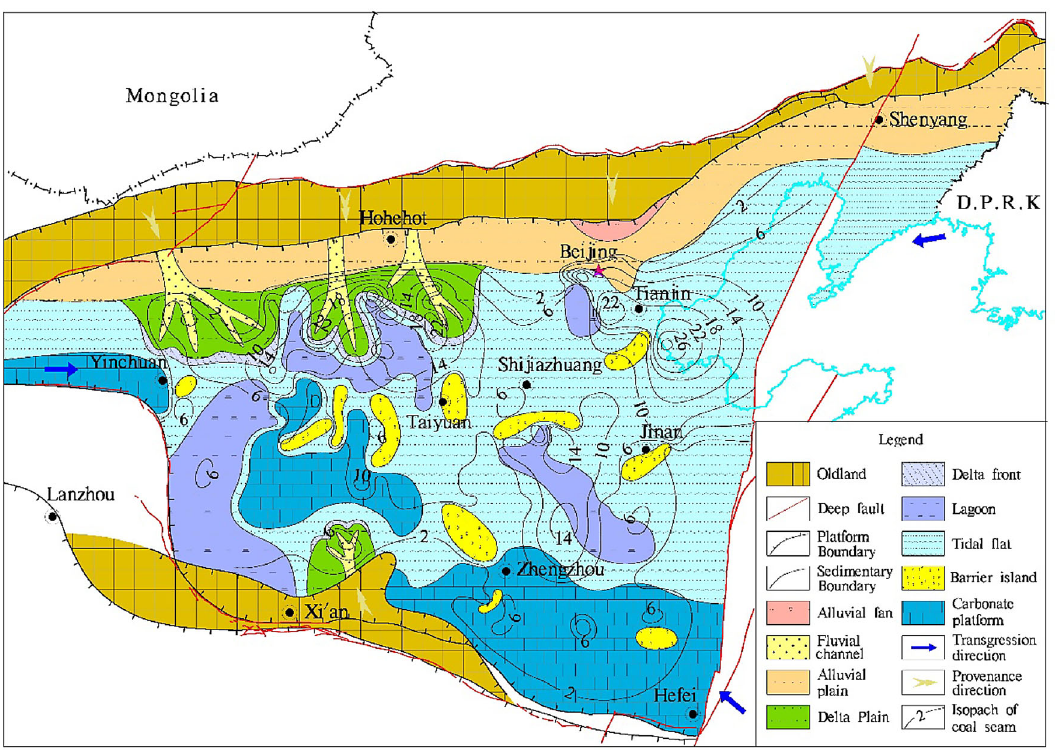
Fig. 5 Sequence-paleogeography and coal-accumulating regularities of SQ2 (most part of Taiyuan Formation) in the North China